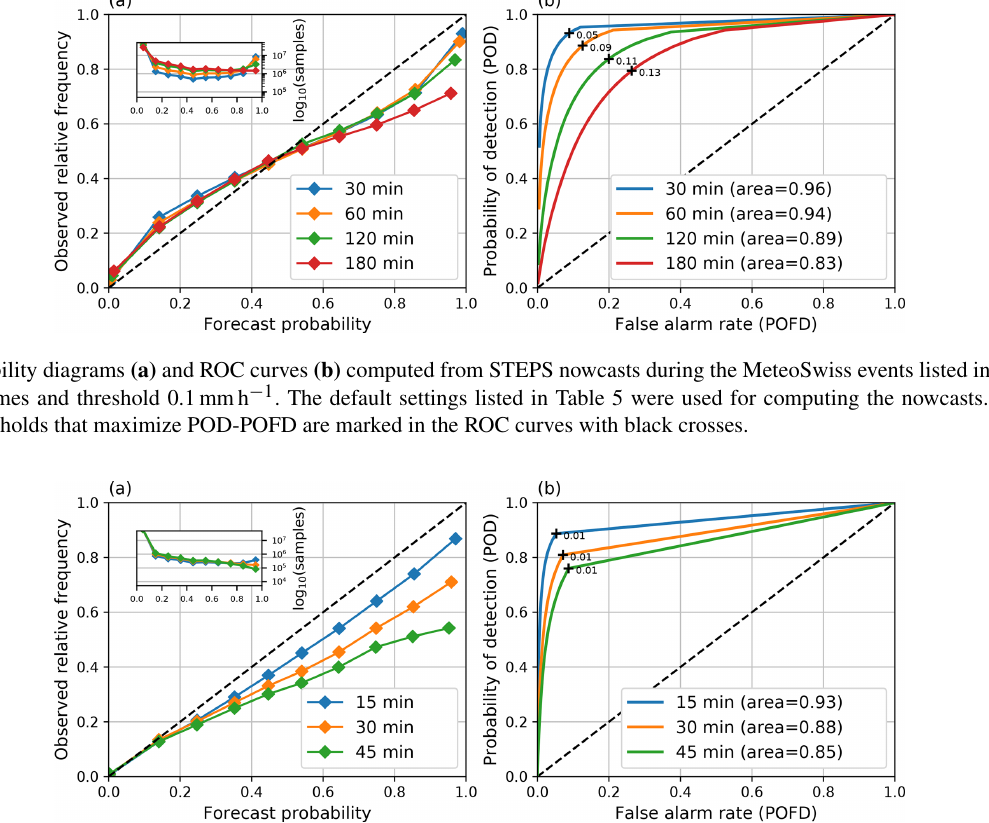
Figure 6. Same as Fig. 5 but for an intensity threshold of 5mmh − 1